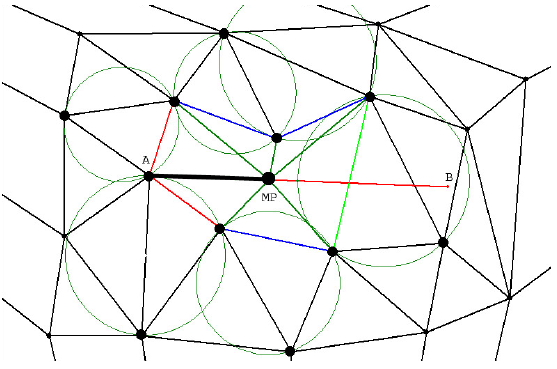
Figure 3 a) “Real” circumcircles to a moving point